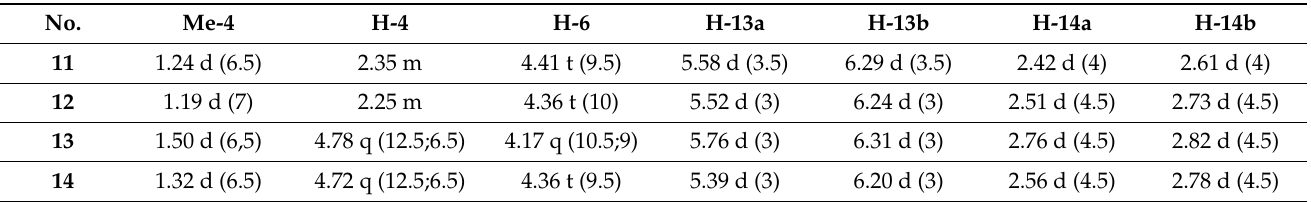
Table 2. Chemical shifts (in ppm) and spin–spin coupling constants ( 1 H NMR, 500.16 MHz, CDCl 3 , δ , ppm, in brackets, in Hz) for estafiatin derivatives 11 – 14